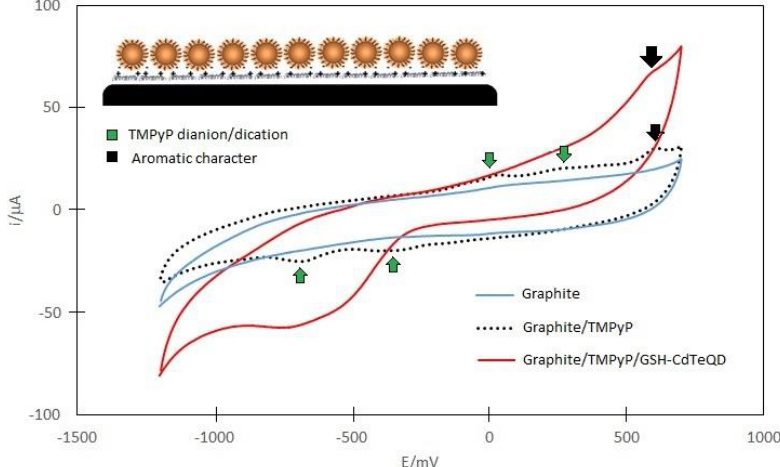
Figure 5. CVs comparative between graphite (solid blue line), graphite modified with TMPyP (dashed black line), and graphite modified with TMPyP/GSH-CdTeQD (solid red line). Insert shows the theoretical arrangement of the TMPyP/GSH-CdTeQD.